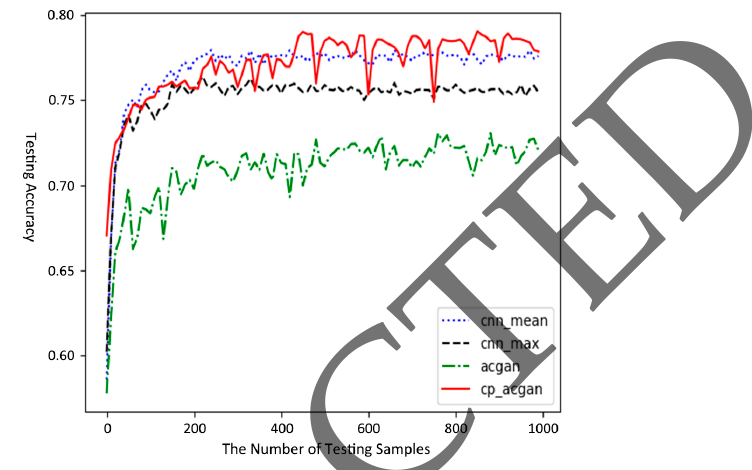
Figure 11. Average testing accuracy comparison on the CIFAR10 testing dataset.